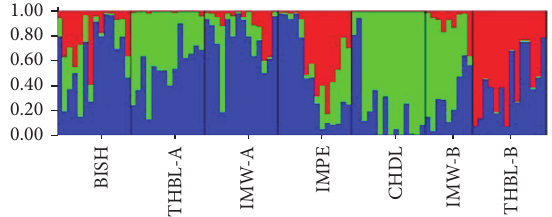
Figure 8: Population structure pattern of 7 populations of M. baccifera generated using STRUCTURE program when 𝐾 = 3